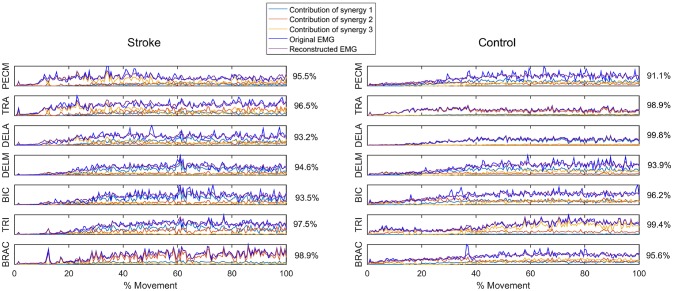
Reconstruction of EMG signal by linear combinations of 3 synergies for a stroke (Left) and control (Right) subject, respectively. Original EMG, reconstructed data, and contribution of each muscle synergy (lines in different color) to the reconstruction are shown in the figure. Muscle VAF is indicated for each muscle.